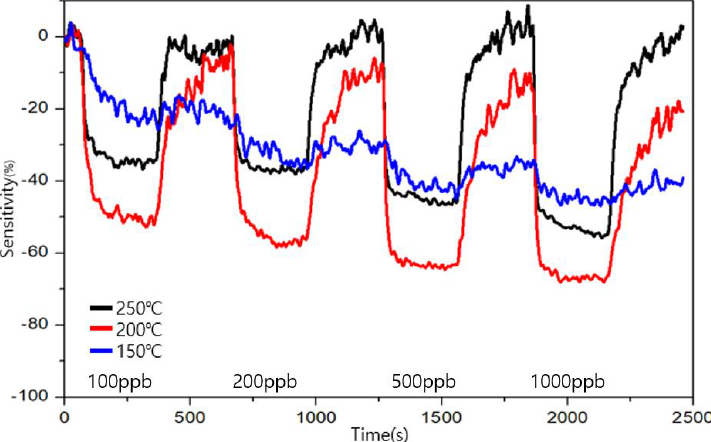
Figure 12. Sensitivity and recovery at different operating temperatures for toluene in the ppb range for the type A sensor.